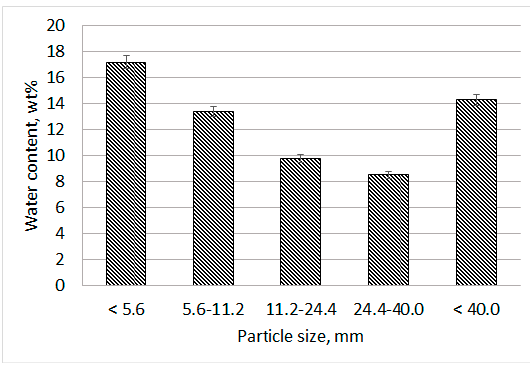
Figure 3. Water content in untreated MSWI bottom ash. Moisture analysis showed that the water content in the untreated BA ranged from 8.50% to 17.16%. The mean value was 12.60 ± 0.39%. The amount of water in BA is not a stable value as the BA is cooled by water in an incinerator. Some of the water immediately evaporates from the hot bottom ash, while some is